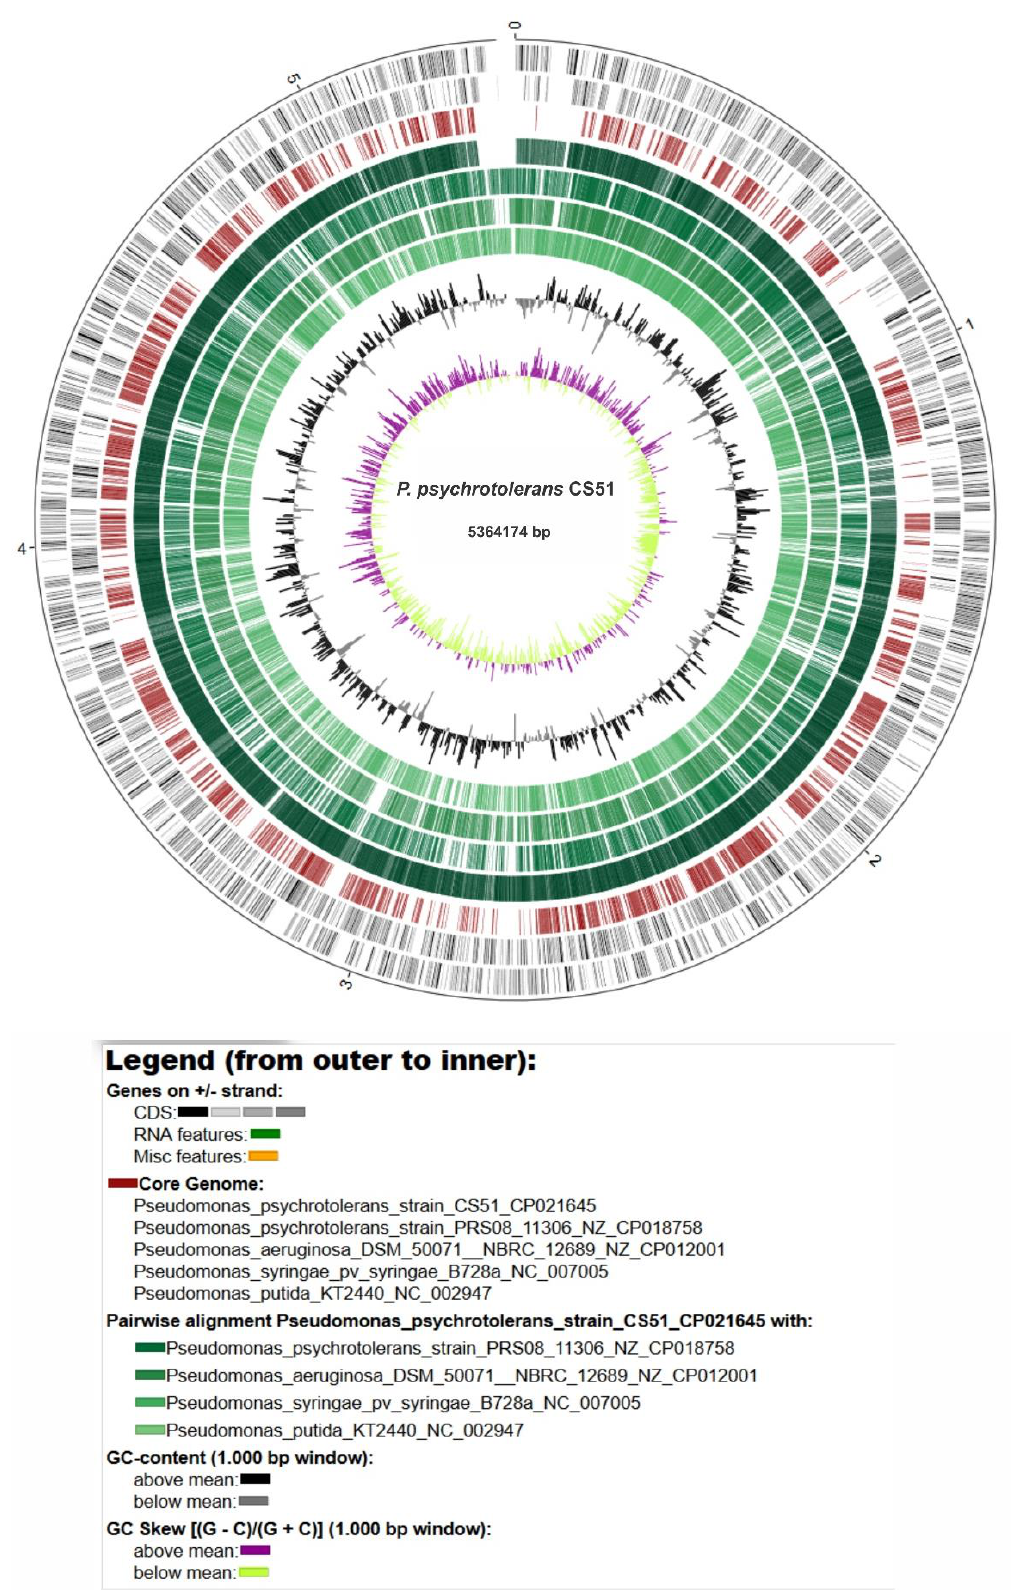
Figure 4. Circular representation of the P. psychrotolerans CS51 genome and comparison with related species. The green color intensity shows the pairwise alignment of P. psychrotolerans CS51 with related species. The inner two circles show the G+C content and skew.